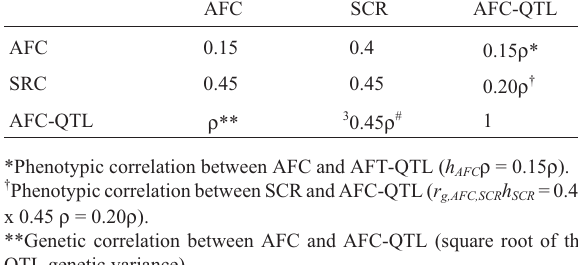
Table 3 - Heritability (diagonal), phenotypic (upper diagonal) and genetic correlations (lower diagonal) for age at first calving (AFC), scrotal cir- cumference (SCR) and the AFC quantitative trait loci (AFC-QTL).